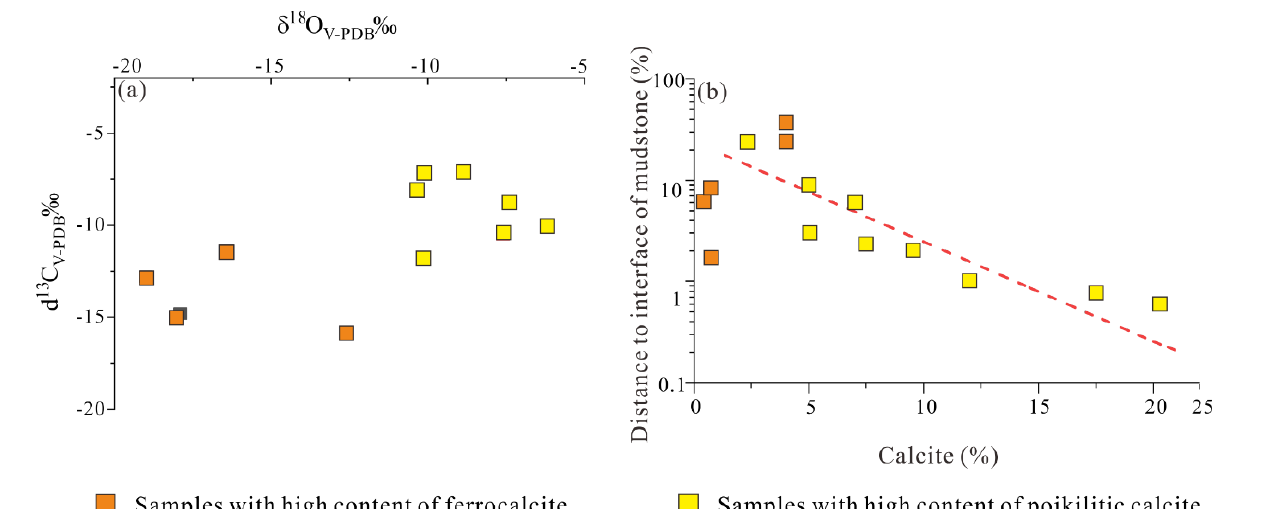
Figure 6. Features of carbon–oxygen stable isotopes for carbonate cements ( a ) and the relationship between the carbonate cement and the distance to mudstone/sandstone interface in Toutunhe formation sandstones ( b ).